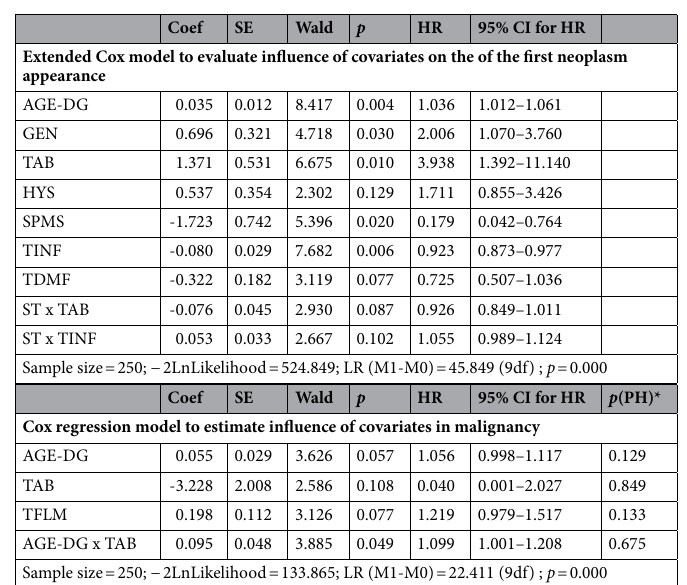
Coef SE HR 95% CI for HR Extended Cox model to evaluate influence of covariates on the of the first neoplasm